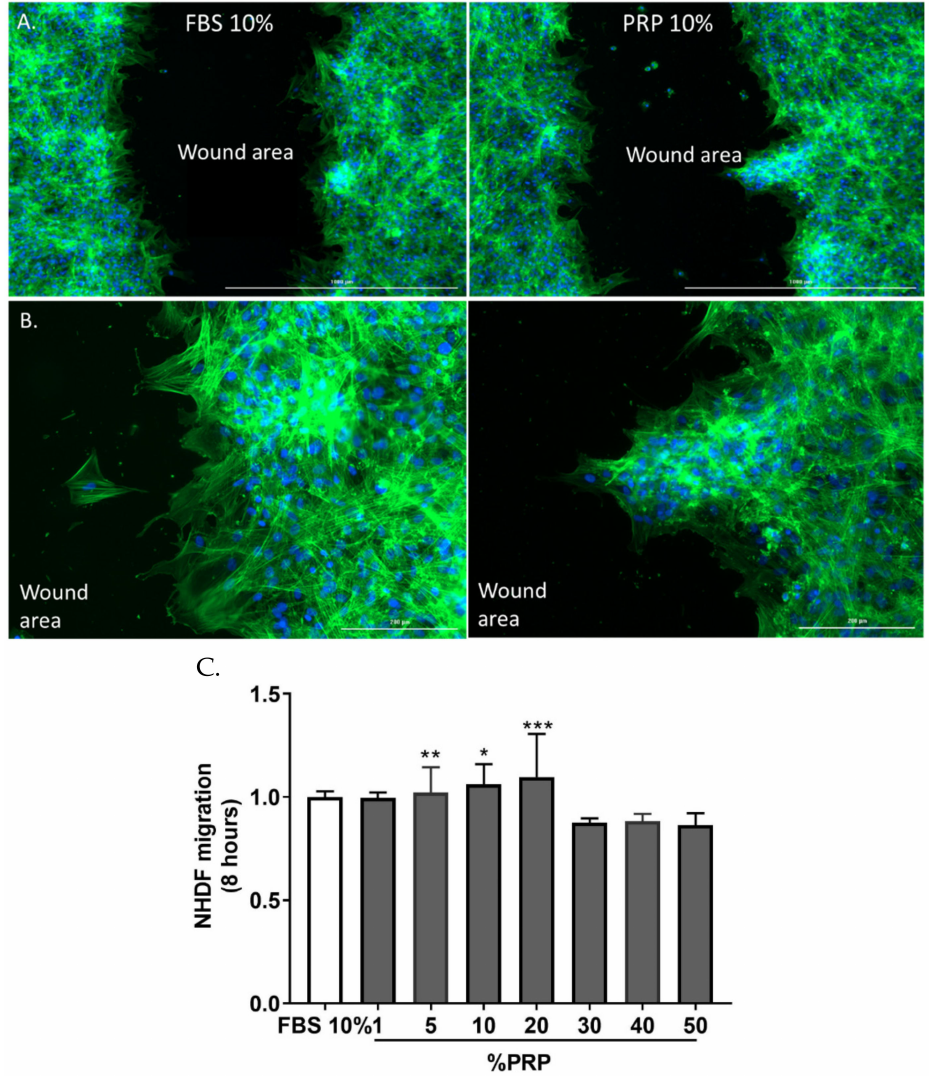
Figure 9. Comparative cellular effects of PRP 10% treatment on cell migration in fibroblast cultures. ( A ) Migrating fibroblasts narrowed the width of the scratch zone as evidenced after 8 h with im- munofluorescence staining with phalloidin. The cell migration front was equally distributed along the scratch border in FBS 10%, while it was less homogeneous in PRP 10%-treated cells. ( B ) Zoom in pictures showing isolated cell migration in FBS 10% cultures and collective cell migration in PRP 10% cultures. Data from Berndt et al. Tissue Engineering. Part A. 2019 [81]. ( C ) Quantification of migration using Image J software (* p < 0.05, ** p < 0.01, *** p <